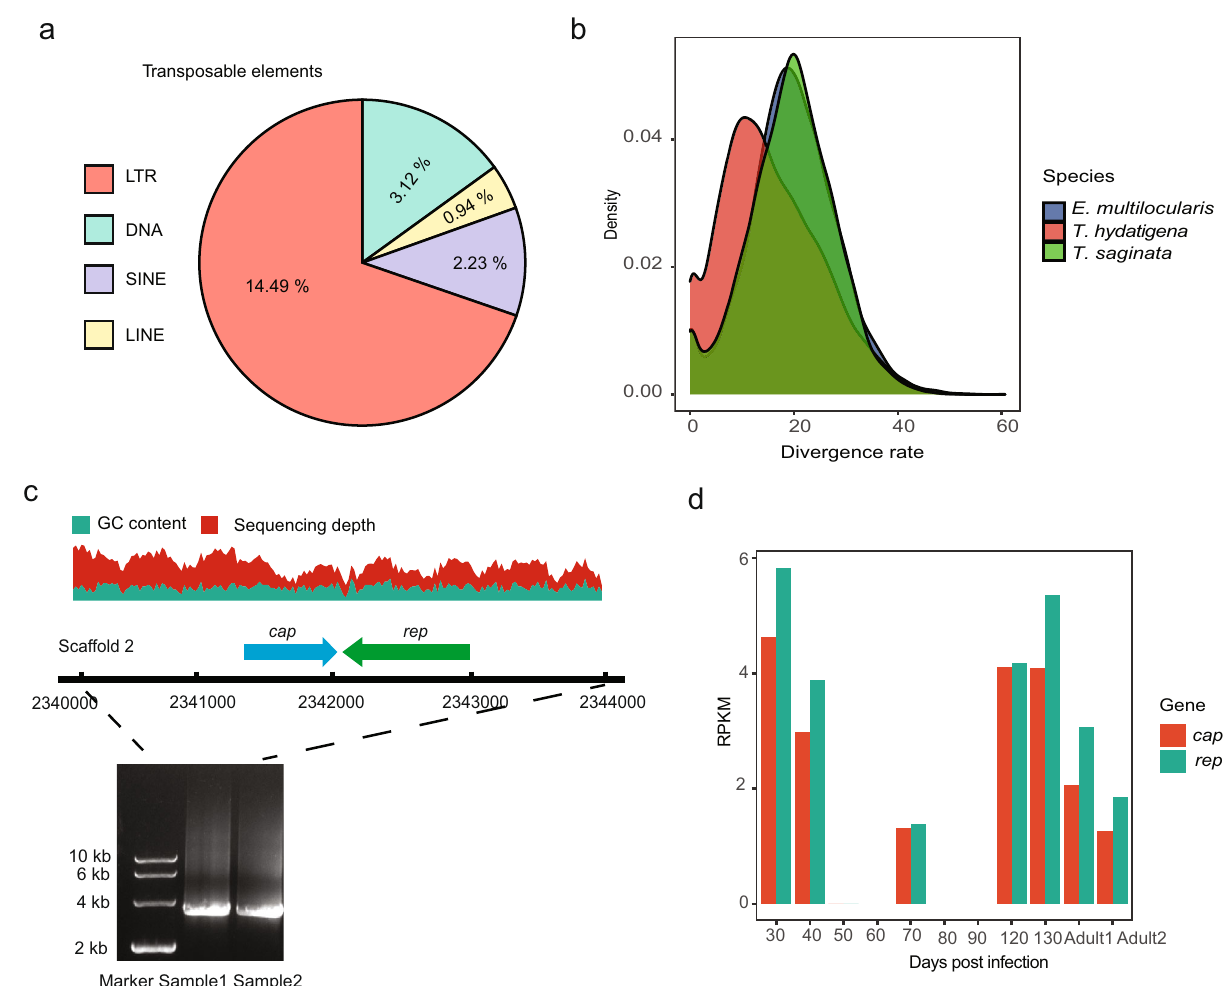
Fig. 2 Expanded repetitive elements and virus-like sequences in the genome. a Schematic overview of the transposable elements repartition in the genome. Transposable elements (DNA transposons [DNA], LTR, SINE, and LINE) as a whole represent about 21% of the genome. The diagram represents the percentage of each TE category over the entire genome (%). b Expansion of TEs in the genome. Divergence from a consensus sequence from each element was calculated by Repeatmasker. c An example of Circoviridae virus-like sequences in the genome. GC content and sequencing depth were calculated using a window size of 20 bp. The presence of the virus genes cap and rep on the scaffold 2 was validated by genomic PCR analysis based on a primer set for ampli fi cation of the complete virus sequence and its fl anking regions. Two independent samples of larvae from different hosts were used for ampli fi cations. d Expression levels of the genes rep and cap of the Circoviridae virus sequence (in panel c ) at different developmental stages. The X -axis represents the tissues of larvae collected at days post infection or adults (Adult1 and adult2 represent samples of immature proglottids and mature proglottids, respectively). FPKM values were calculated from the RNA-seq data (see ‘ Methods ’ ) of